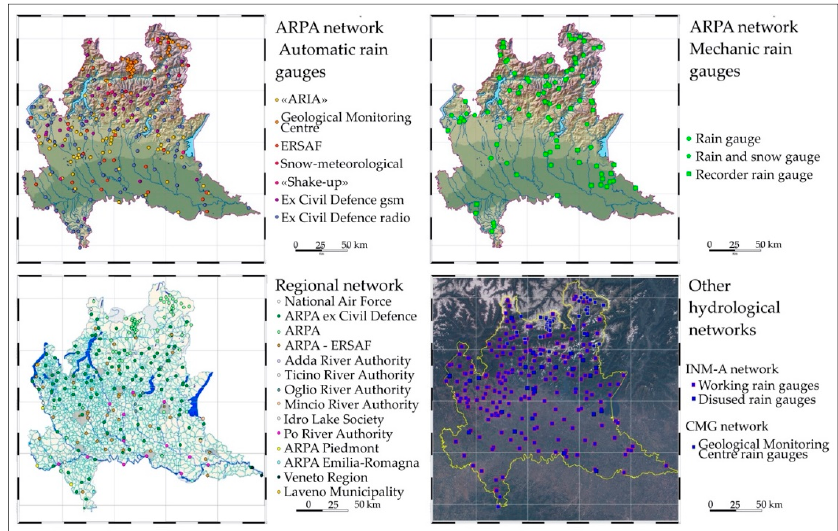
Figure 6. Rain gauge networks in the Lombardy Region. ARPA = Regional Agency for the Environmental Protection; ERSAF = Regional Agency for Agricultural and Forestry Services; ARIA = Aria Network consists of instruments installed near cabins belonging to the Air Quality Detection Network; INM-A = Integrated Noise Model Network; CMG = Meteorological automatic acquisition network designed for monitoring some landslides in Lombardy (Sondrio province).